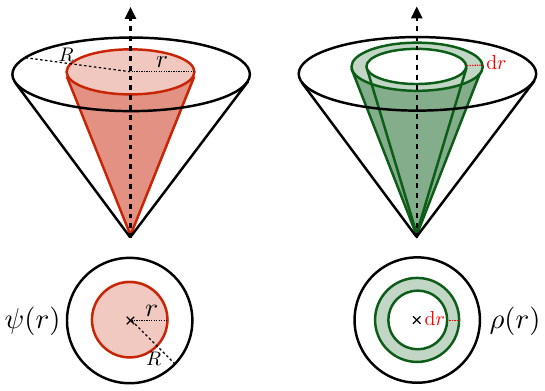
Figure 1 . The integrated (di(cid:11)erential) jet shape, shown in the left (right) panel, is the fraction of the jet transverse momentum contained in a circle (annulus) in ( (cid:17); (cid:30) ) coordinates, centered on the jet